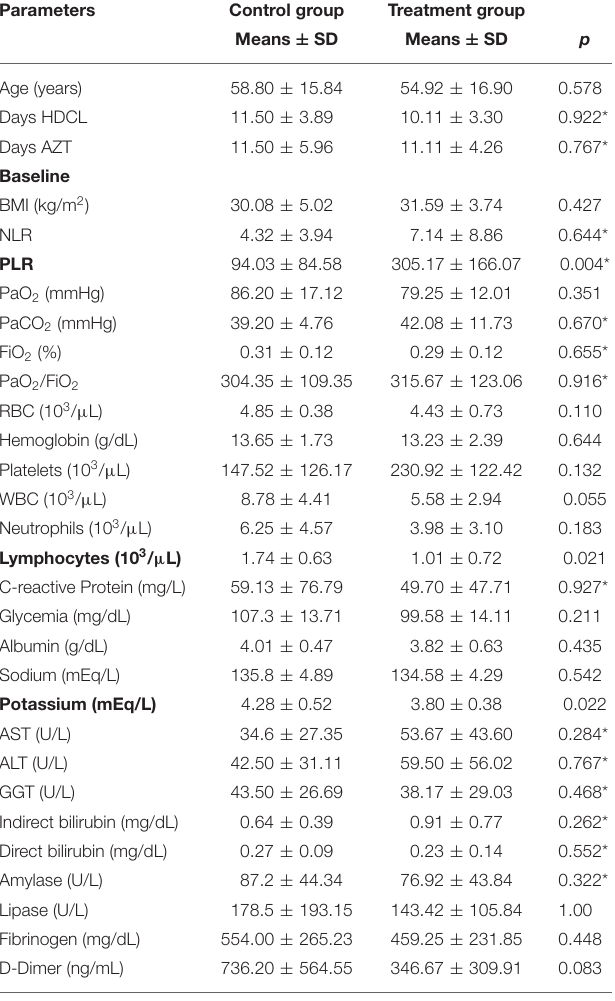
TABLE 1 | Differences between control group and treatment group at baseline. Parameters